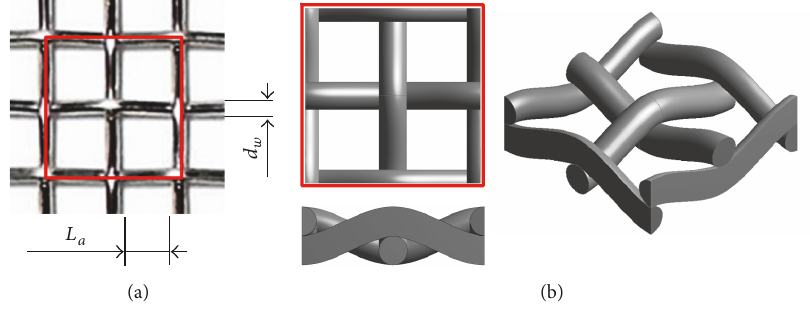
Figure 3: Geometric modeling of a woven metallic mesh: (a) metallic mesh; (b) geometric model of a unit cell.